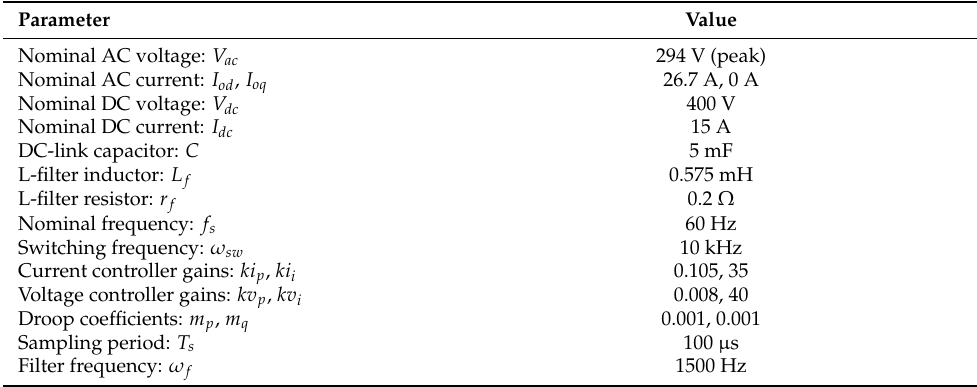
Figure 6. Simulink model of droop-controlled inverter with LCL filter connected to a ZIP load. Table 2. Grid and controller